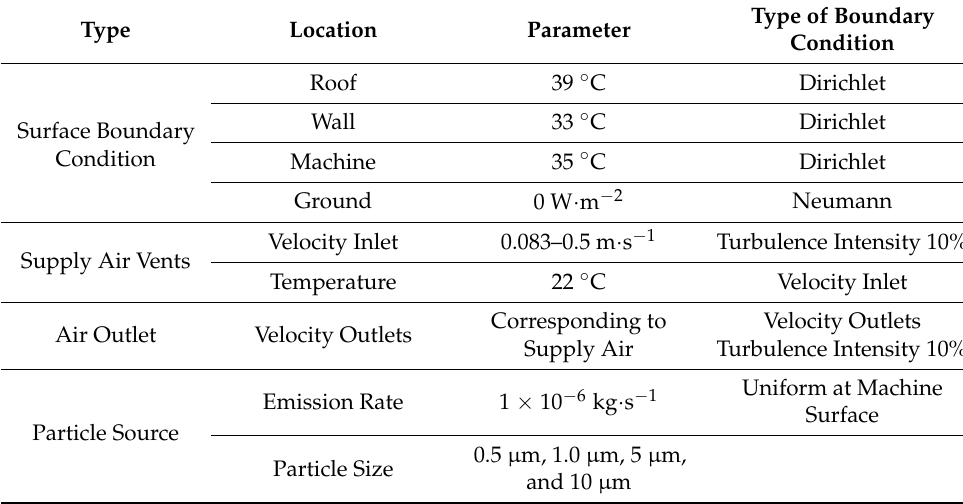
Table 2. CFD boundary condition